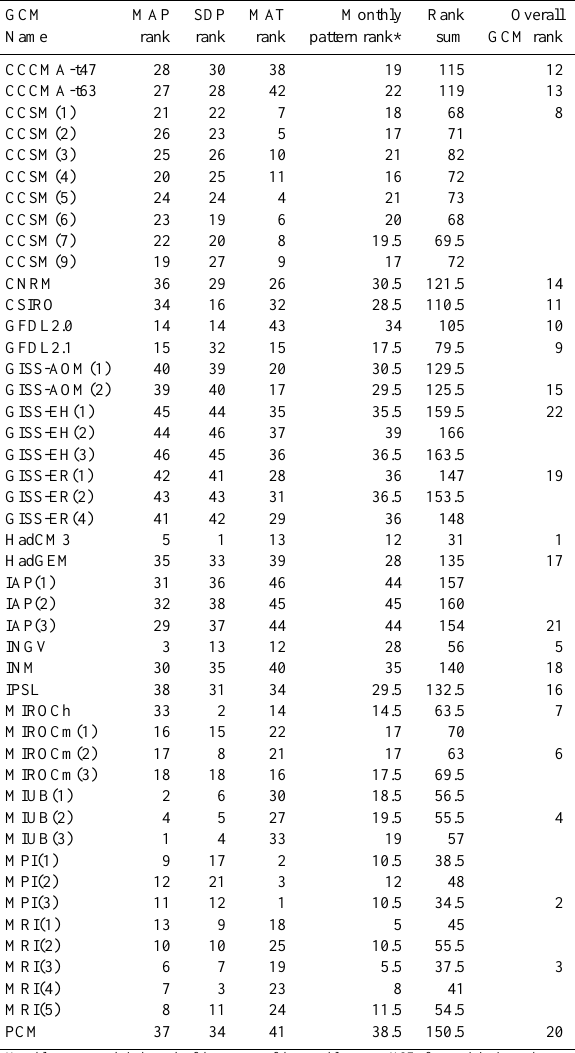
Table 8. CMIP3 GCM run rank (rank 1 = best) based on Nash– Sutcliffe efficiency (NSE) values from comparison of 20C3M and concurrent observed grid cell